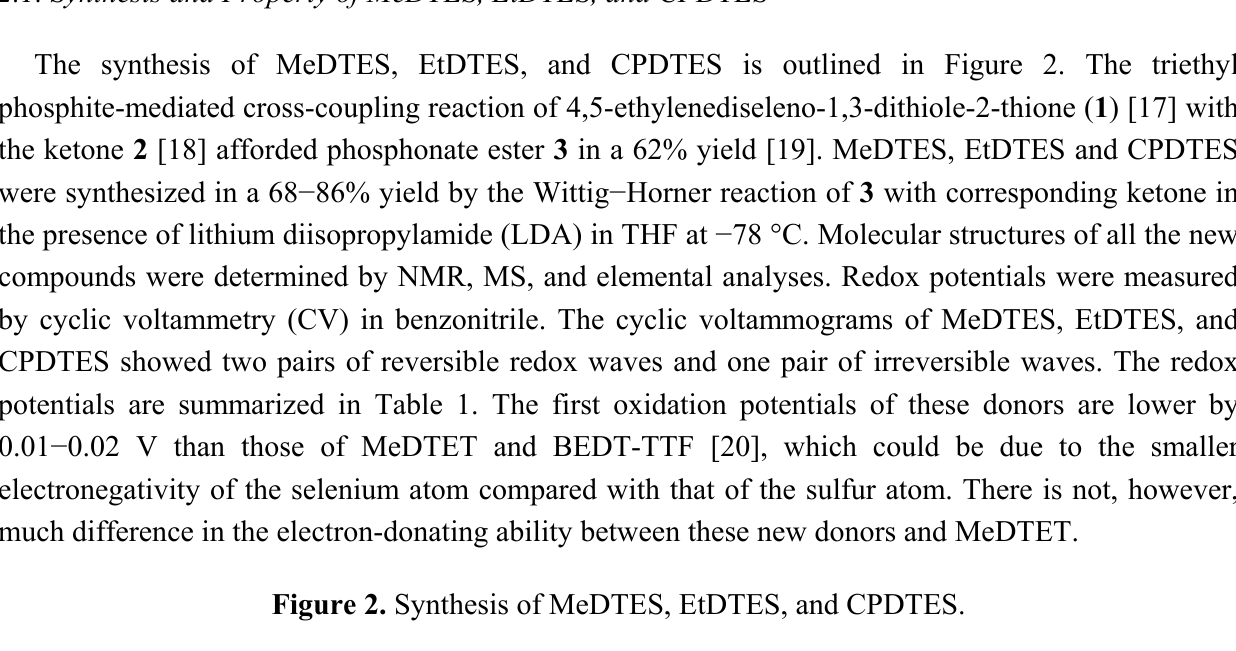
Figure 2. Synthesis of MeDTES, EtDTES, and CPDTES.